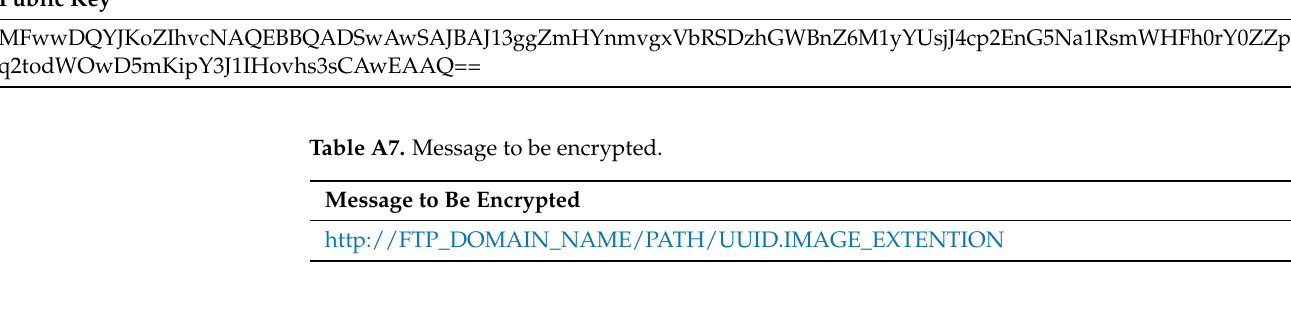
Table A8. Output/message to decrypt: [Encrypted Output on Base64].